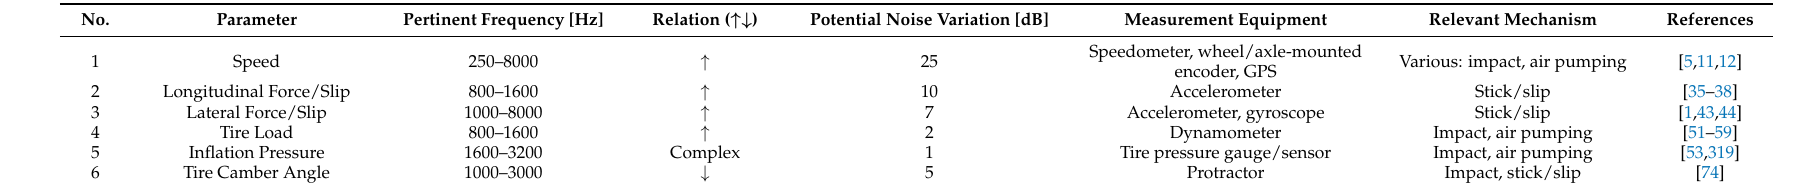
Table 15. Summary of driver influence parameters affecting TPIN.